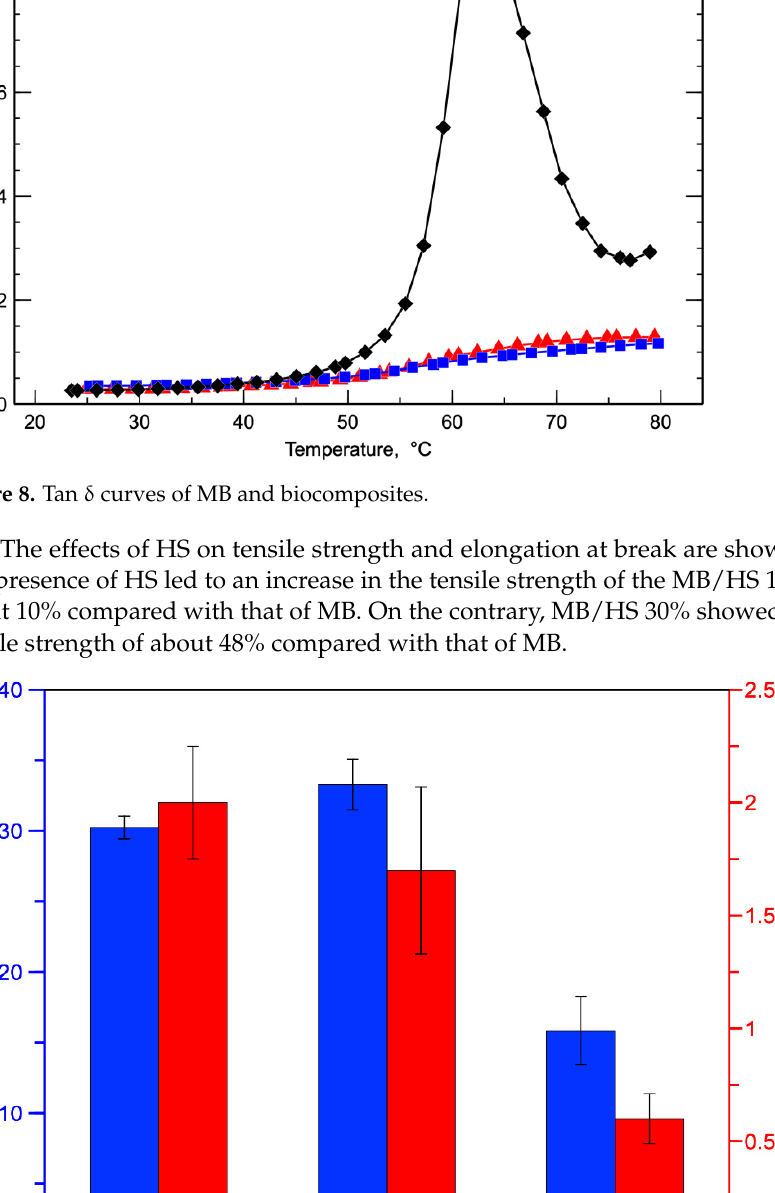
Figure 10. Stress–strain curve of MB and biocomposites. Indeed, the HS provoked a decrease in the elongation at break of the polymer matrix. In more detail, the elongation at break of MB was 2.0%, while MB/HS 10% and 30% showed elongation at break values of about 1.7% and 0.6%, respectively. Figure 11 shows the SEM micrographs of the fracture surfaces of the two biocompo- site materials. The first feature observed was that many particles were pulled out of the matrix, leaving small holes. In addition, the lack of a strong interaction between the HS